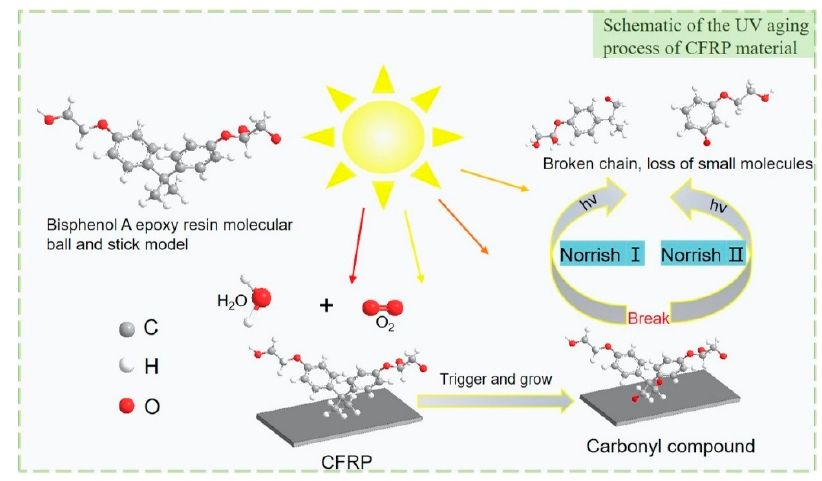
Figure 3. UV aging of CFRP material.